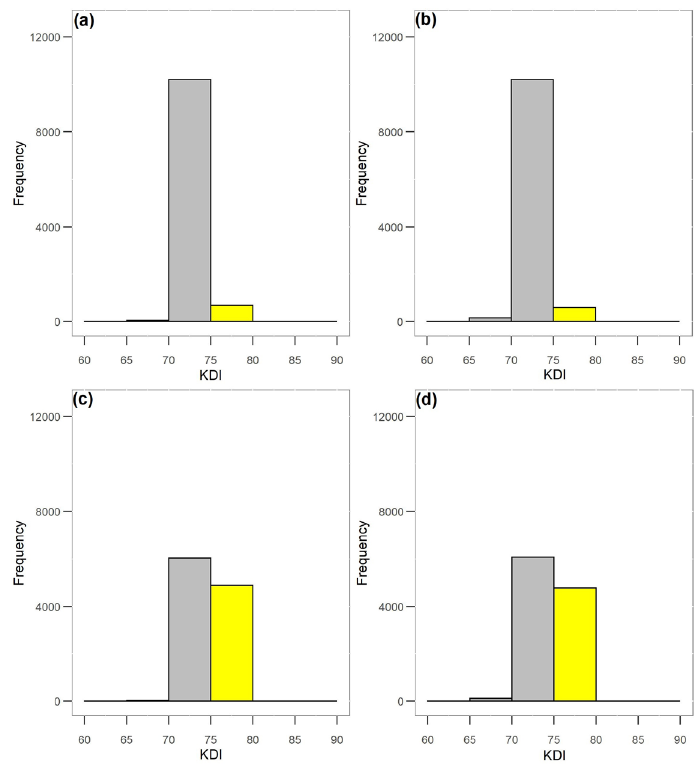
Figure 9. Histograms of the future scenarios of the daily KDI classification for the periods 2021- 2050 according to scenarios A1B (a) and A2 (b) , and 2051-2080 for scenarios A1B (c) and A2 (d) , from the results of the models for Area 02. The gray color indicates the comfortable range, while yellow represents the uncomfortable range by